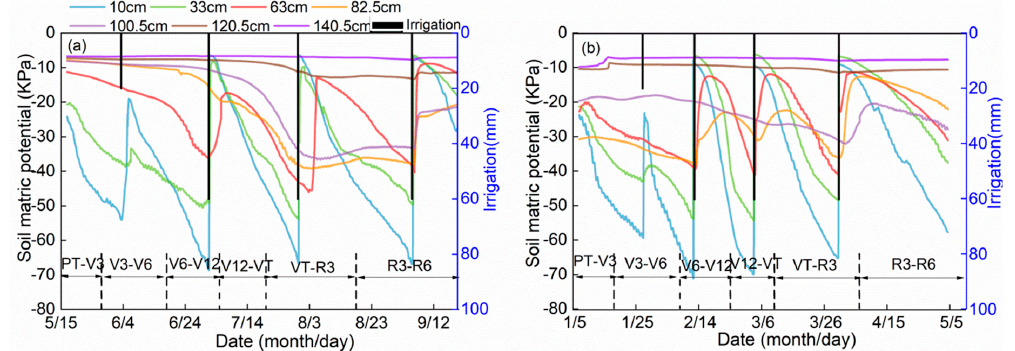
Figure 4. Half-hourly variations in soil matric potential (SWP) at different depths in ( a ) T-control and ( b ) T-warm experiments, respectively.